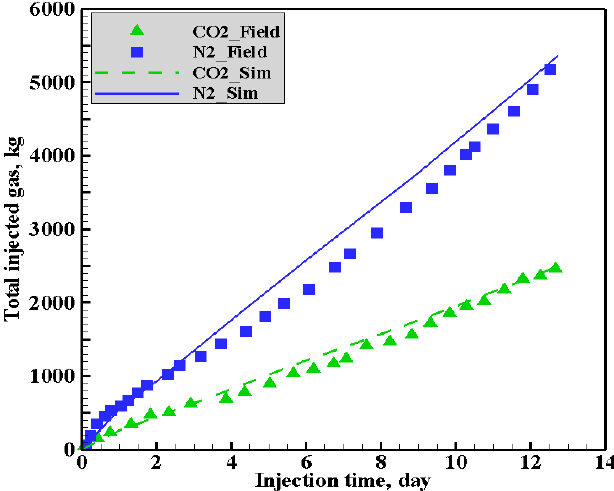
Figure 7. Measured and simulated Cumulative CO 2 and N 2 during the injection.